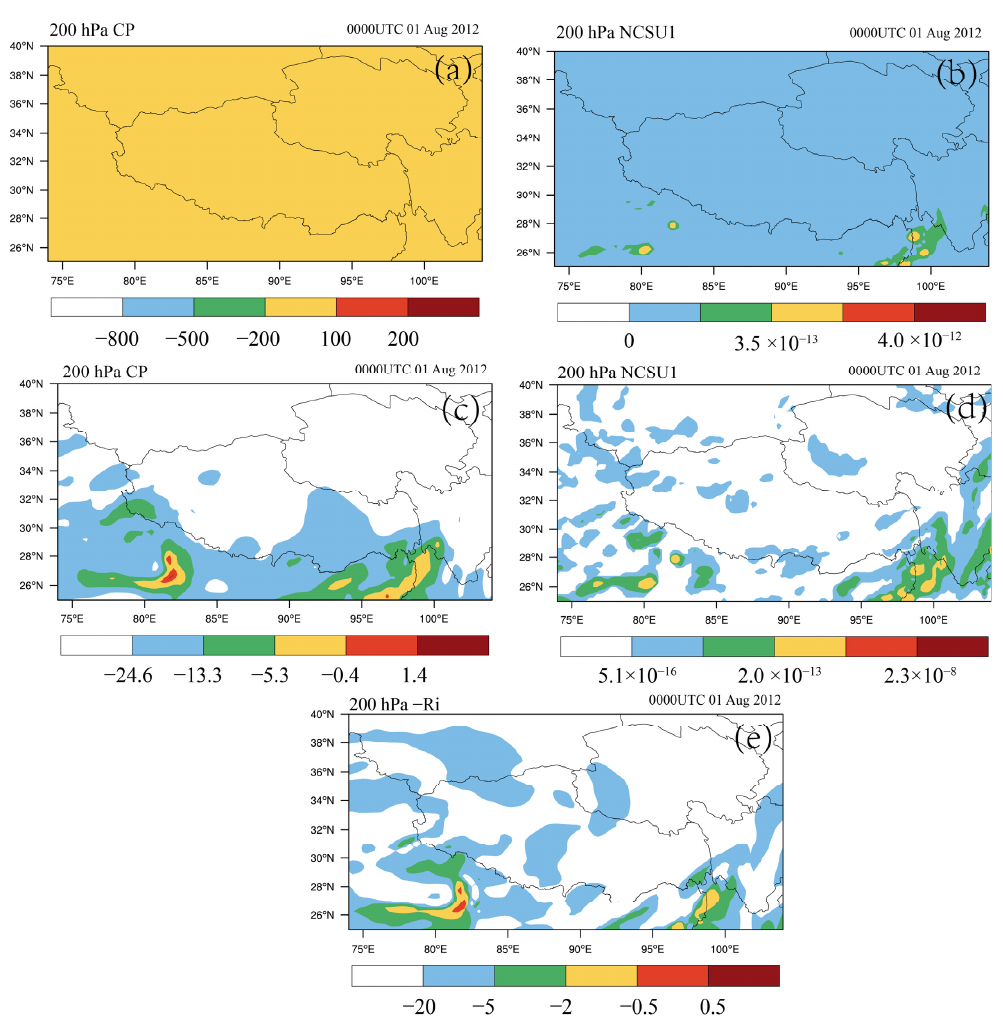
Figure 1. 200 hPa ( a ) CP index and ( b ) NCSU1 at 0000 UTC on 1 August 2012, color-coded as empirical thresholds. 200 hPa, ( c ) CP index, ( d ) NCSU1, and ( e ) Ri at 0000 UTC on 1 August 2012, color-coded as thresholds reclassified with negative Richardson number percentiles.